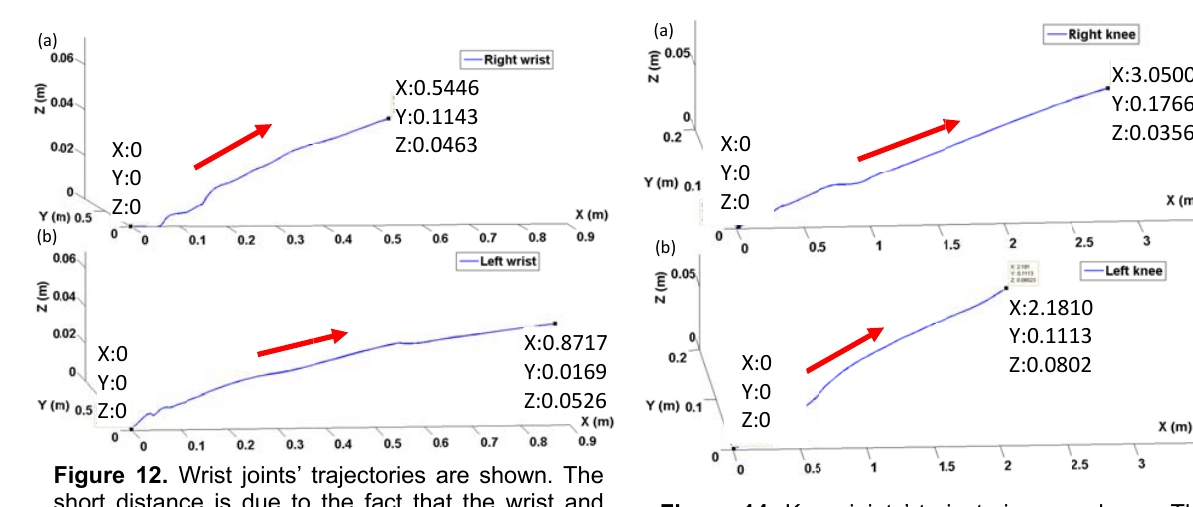
gure 14. Kne tance is long